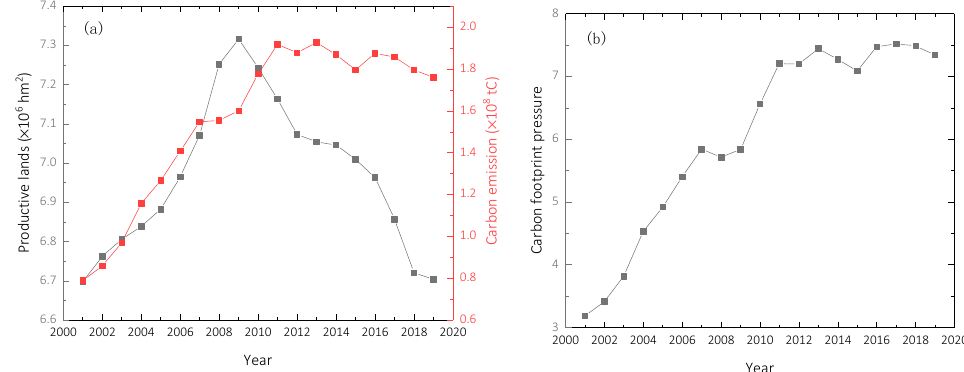
Figure 2. Changes in ( a ) productive lands and carbon emission, and ( b ) carbon footprint pressure in the YRD from 2001 to 2019.